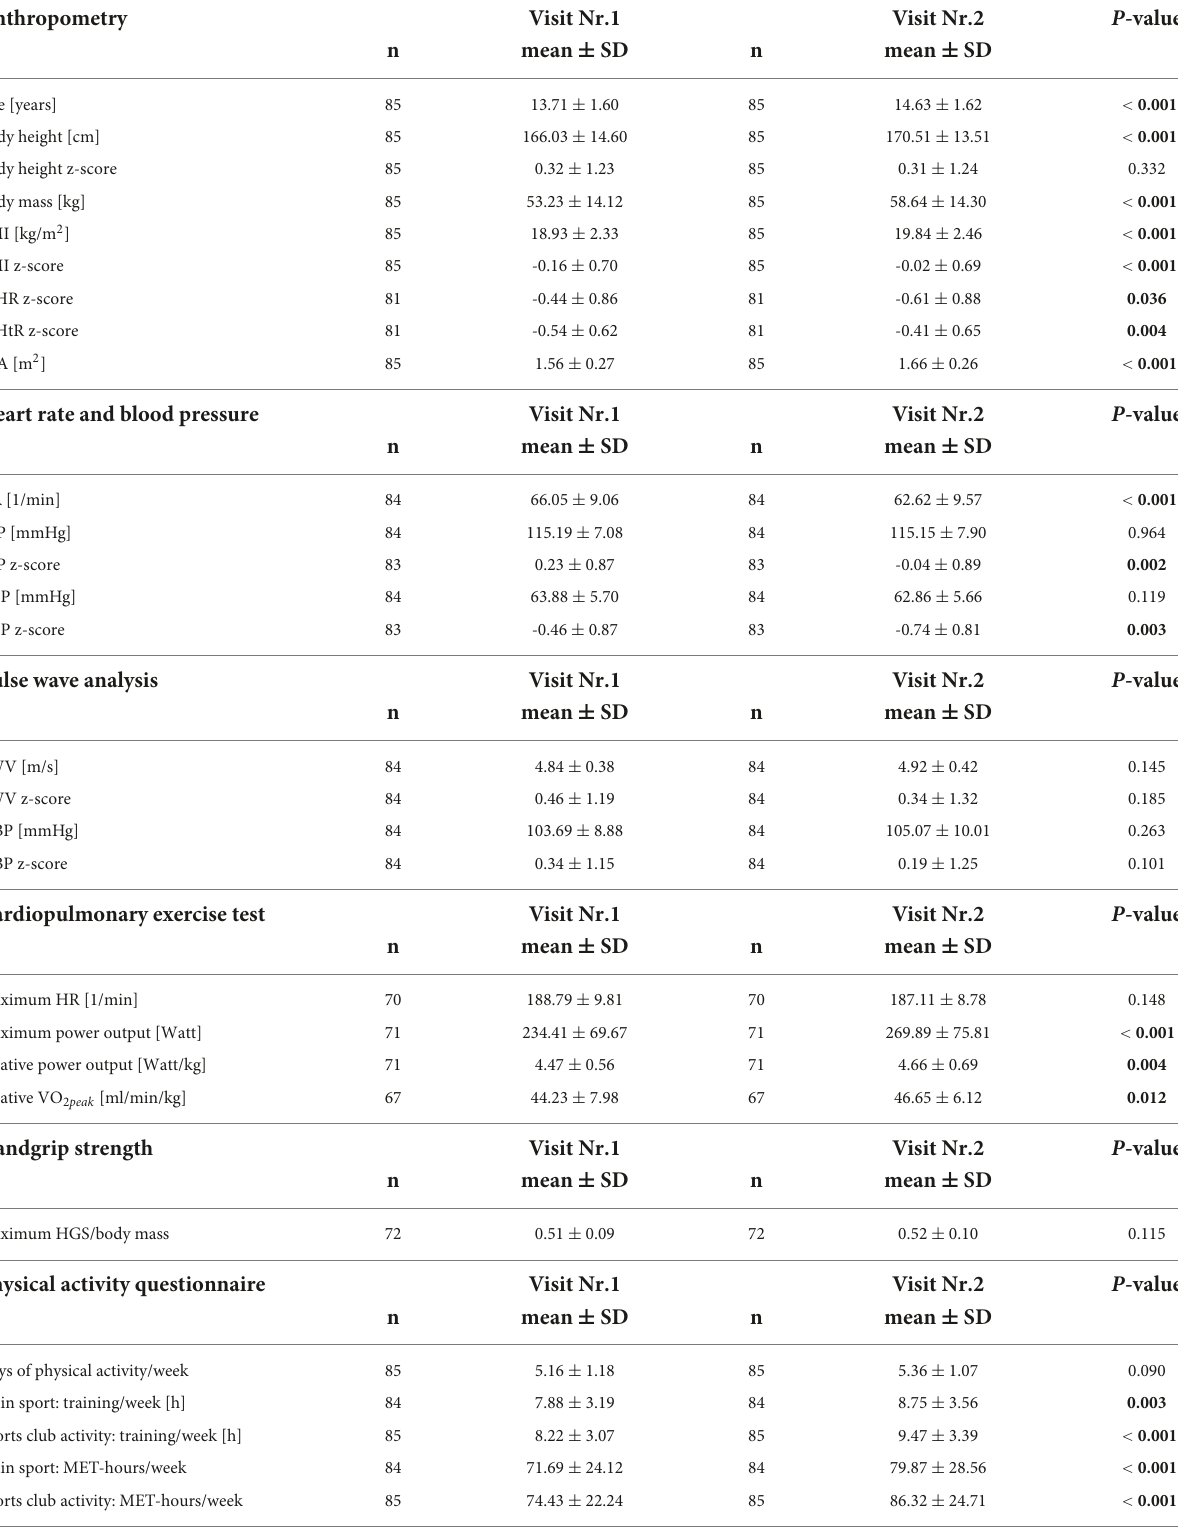
TABLE 4 Results of the longitudinal sub-sample regarding anthropometry, heart rate, blood pressure, pulse wave analysis, data on physical performance and training time, and echocardiographic data. Anthropometry Visit Nr.1 Visit